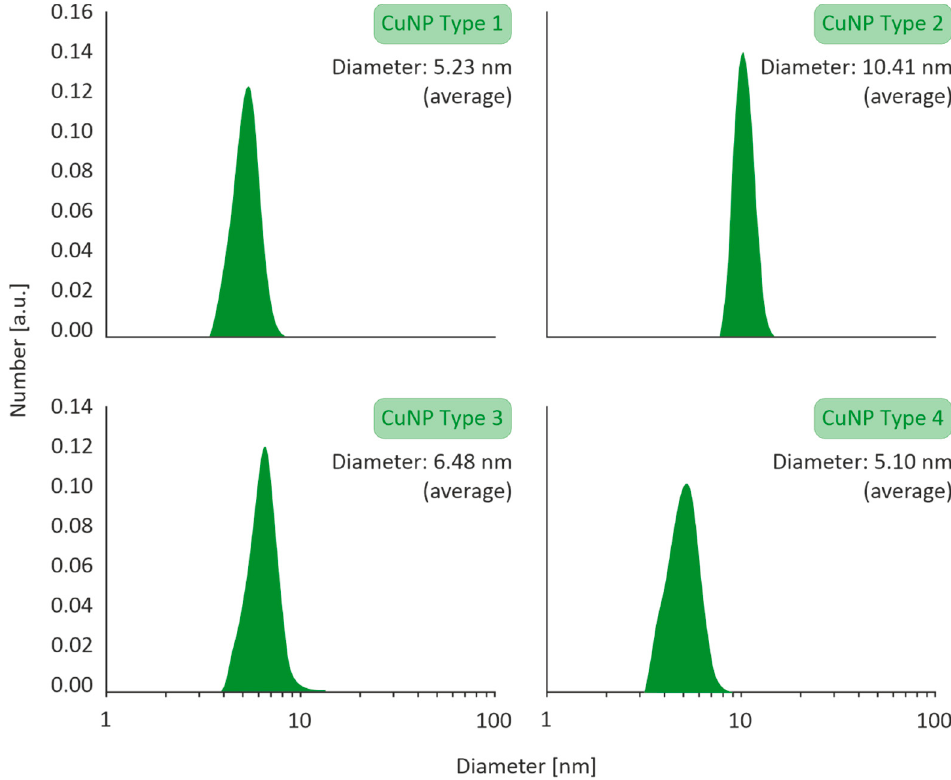
Figure 1. Particle size distribution of Type 1–4 CuNPs assessed by Dynamic Light Scattering (DLS) with a VASCO 3 analyzer by Cordouan Technologies.